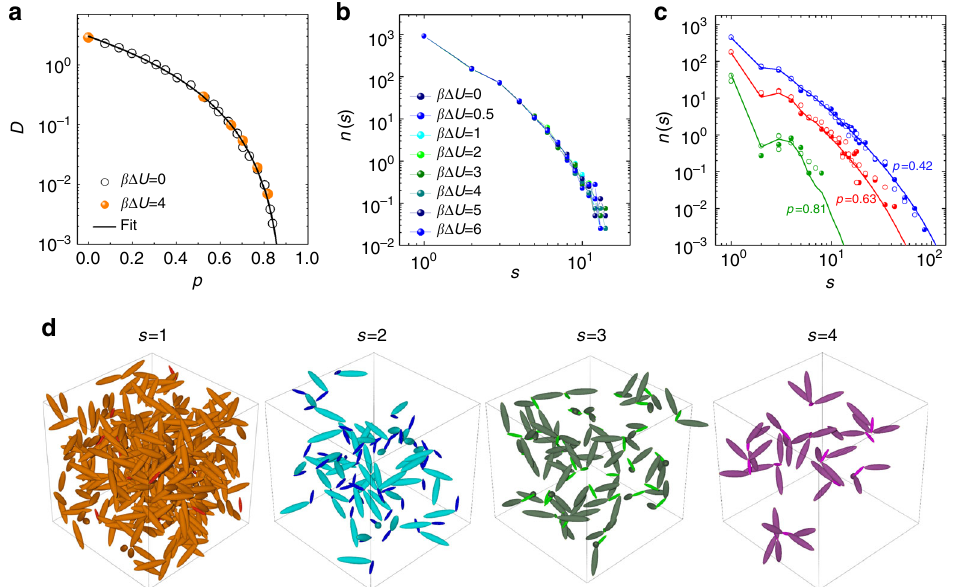
Fig. 4 System ’ s diffusivity and cluster size distribution. a Average diffusion coef fi cient D determined from the particle mean-squared displacements (Methods section) for the system without barrier and with barrier. The p dependence is described by D = D 0 [( p 0 − p )/ p 0 ] γ with γ = 2.69, p 0 = 0.902, and D n ( s ) of the size s of clusters present at p = 0.2 in systems with fi xed barrier (as indicated), 0 the diffusion in the initially unbonded state. b Distribution providing evidence that the cluster size distribution is independent of both presence and height of the barrier. c Cluster size distribution during non- autocatalytic reaction with barrier β Δ U = 4 (closed symbols) and during autocatalytic reaction of equal initial barrier (open symbols). Solid lines represent Flory-Stockmayer predictions 24 . The comparison is shown at three values of p , before and after percolation ( p gel = 0.5). No difference emerges, providing evidence that the distribution of clusters at any given p is independent from the autocatalytic nature of the reaction. d Populations of clusters of different size, from monomers to tetramers, in the system reacted up to p gel = 0.5. In each population, big and small particles are distinguished by color